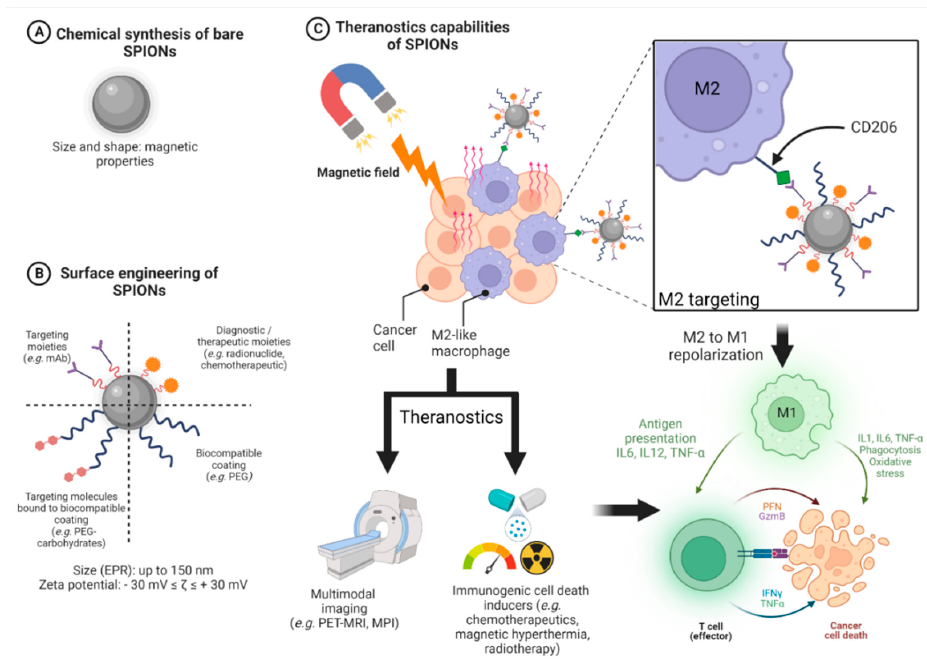
Figure 2. Design and theranostic applications of SPIONs suitable for MHT and macrophage target- ing in cancers. Abbreviations. PEG: Poly-Ethylene Glycol; mAbs: monoclonal antibodies; EPR: Enhanced Permeability and Retention; MRI: Magnetic Resonance Imaging; MPI: Magnetic Particle Imaging; PET: Positron Emission Tomography; IL: Interleukin; TNF- α : Tumor Necrosis Factor- α ; AMF: Alternating Magnetic Field; PFN: Perforins; GzmB: Granzyme B; IFN γ : Interferon γ . Created with BioRender.com.